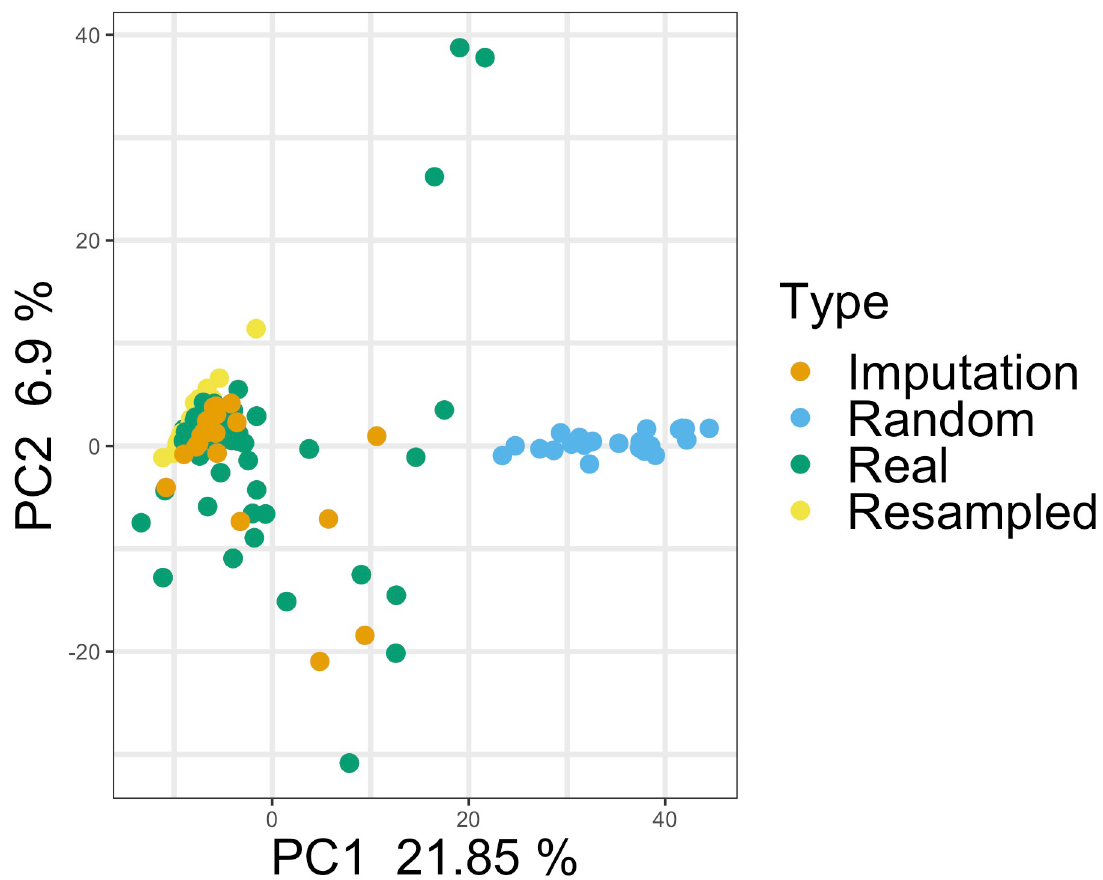
Fig 1. Principal component analysis of real and fake samples. Copy number data for the real and fabricated samples are shown. The fabricated data created via random number generation is clearly distinct from all other data. Fabricated data created via resampling or imputation appears to cluster very closely with the real